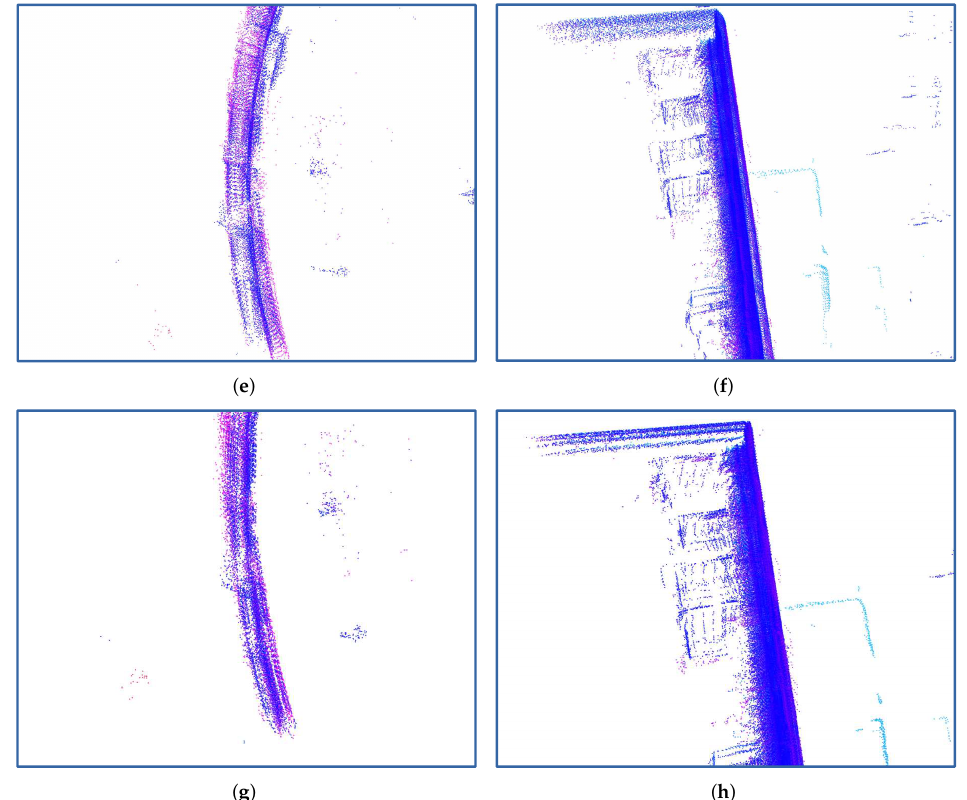
Figure 5. Point cloud accumulation results. ( a , b ) are two example scenarios. These two cropped areas are shown in detail in the lower part of images using the green ellipse; ( c , d ) present the accumu- lated point cloud using linear interpolation between two visual localization system measurements; ( e , f ) show the accumulated point cloud using the fusion results from the pose-graph-based approach; ( g , h ) visualize the accumulated point cloud using our fusion